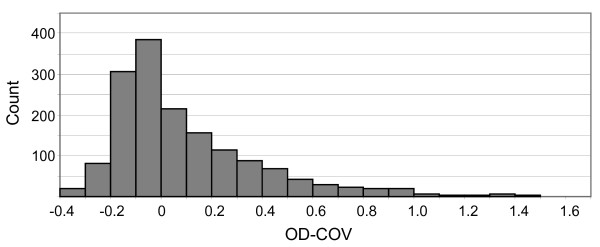
Distribution of IgG OD-COVs of all study participants (n = 1596).